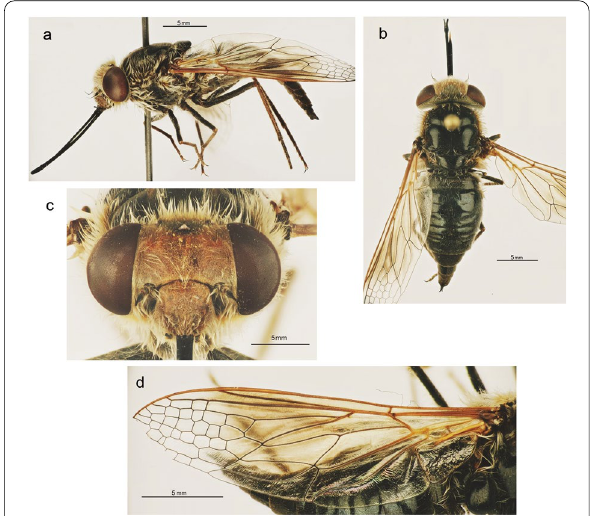
Fig. 1 Nemestrinus aegyptiacus (Wiedemann) female. a Habitus, lateral. b Same, dorsal. c Head, frontal. d